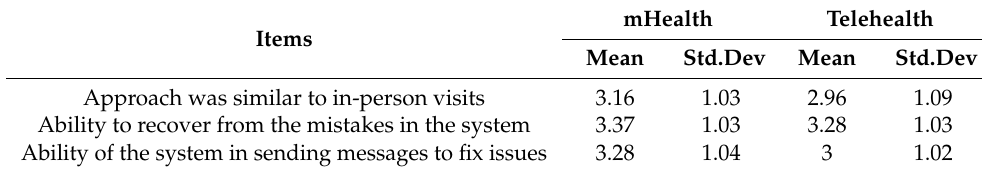
Table 10. Reliability of mHealth and Telehealth.